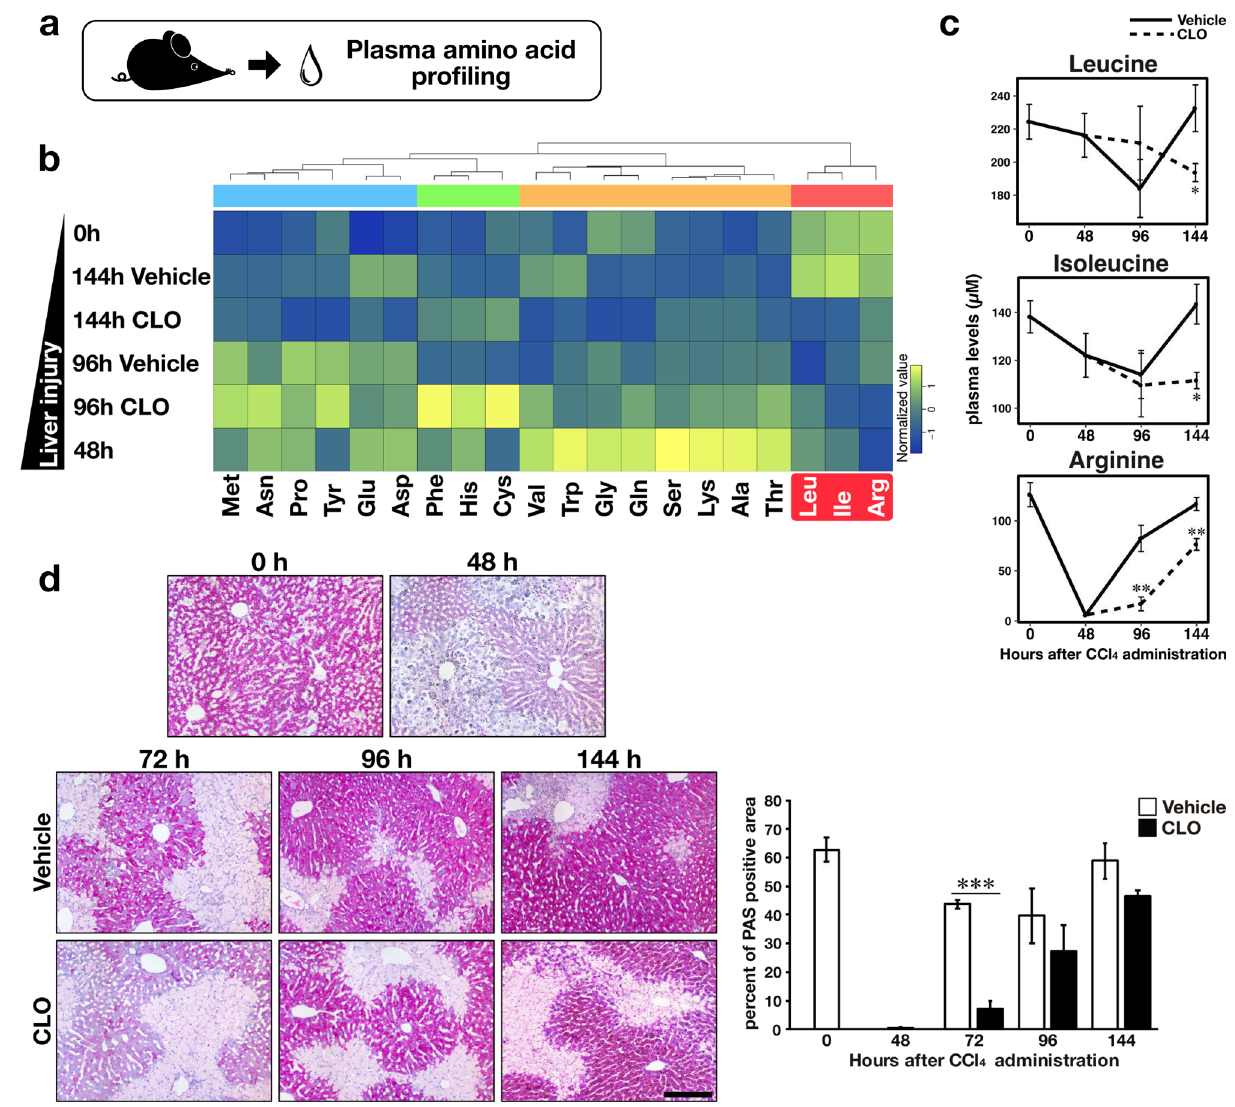
Figure 5. The effects of tissue remodelling suppression on the recovery of amino acid and carbohydrate metabolism during regeneration. ( a ) Plasma amino acid levels were quantified by LC/MS/MS. Changes in plasma amino acids levels are shown as a heatmap ( b ). The coloured blocks indicate group mean levels. Hierarchical clustering was performed using the correlation-based distance with the ward.D2 clustering method. ( c ) Plasma levels of leucine, isoleucine, and arginine. ( d ) Representative Periodic acid Schiff (PAS) stained images (scale bar, 100 µm). Intracellular glycogen is stained purple. Images were quantified as follows: purple dye-stained areas were divided by total tissue areas of the same images. White bars indicate vehicle- treated mice and black bars indicate CLO-treated mice. Data are presented as mean ± SEM (n = 6/group). Intergroup differences between the vehicle and CLO group at each time-point were compared using Welch’s t -test; *p < 0.05, **p < 0.01, ***p < Schenk et al. used pharmacokinetic modelling to study the relationship between CYP zonation patterns and in vivo activity. CYP activity decreased when hepatocytes were lost to injury soon after CCl 4 administration 25 . The liver drug-metabolising capacity decreased because the surviving hepatocytes were dysfunctional, although they continued to express CYP. In contrast, we clearly showed that the hepatocytes of injured zones expressed Cyp1a2 and Cyp2e1 during regeneration, compensating for local dysfunction caused by the death of other hepatocytes even when tissue remodelling was suppressed. Hence, the drug-metabolising capacity of the liver is maintained during regeneration after acute liver injury. The compensatory mechanisms remain unknown; further research is required. Plasma amino acids have been investigated as potential biomarkers to predict the severity of non-alcoholic fatty liver disease 26 and the mortality of end-stage liver diseases 27 . Holecek et al. reported that the plasma BCAA levels of CCl 4 -injured rats are lower than those of intact rats during the regeneration phase after acute liver injury 28 . We demonstrated that suppressing tissue remodelling decreased plasma levels of leucine and isoleucine